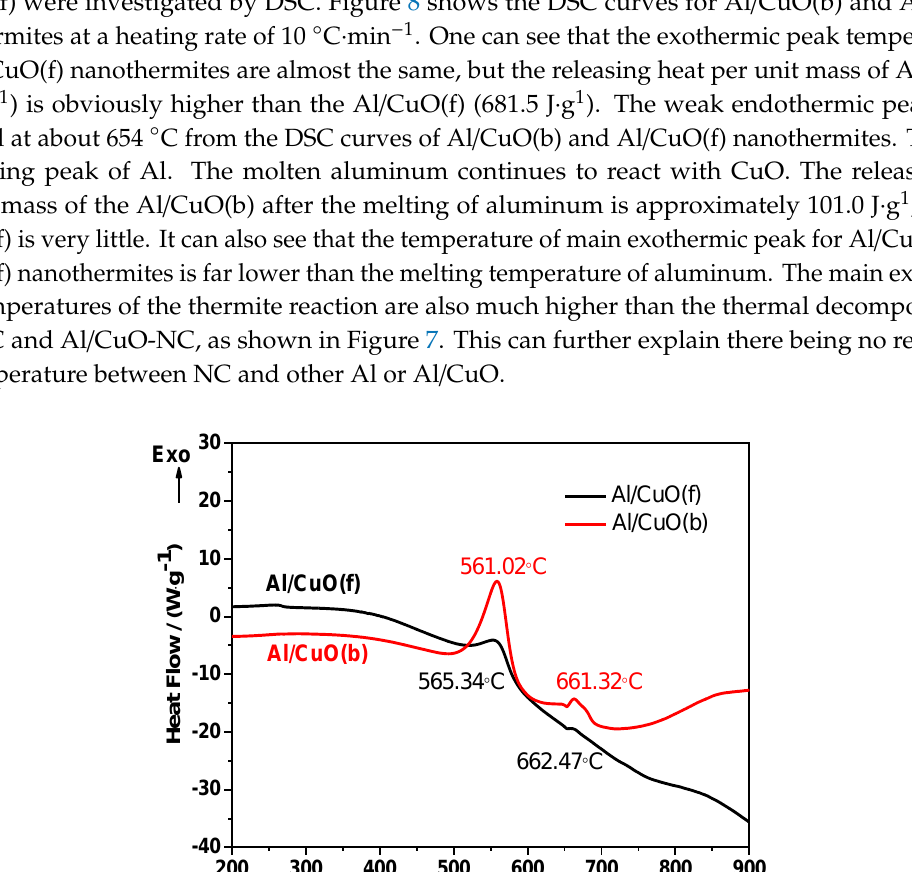
Figure 8. DSC curves of Al/CuO(f) and Al/CuO(b) at a heating rate of 10 °C·min –1 .